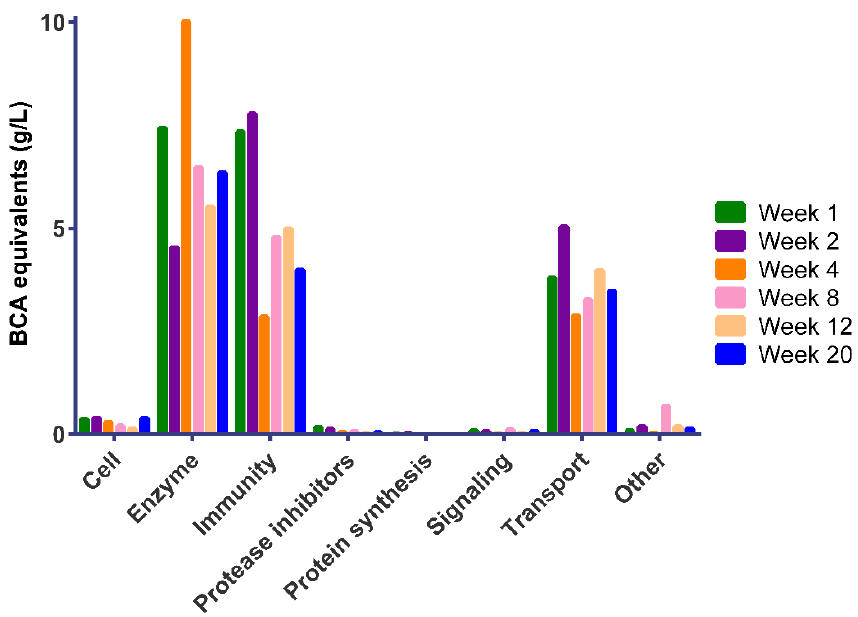
Figure 3. Averaged BCA equivalent values (g/L) of serum proteins for human milk from seven Chinese mothers categorized per biological function over a 20-week lactation period.